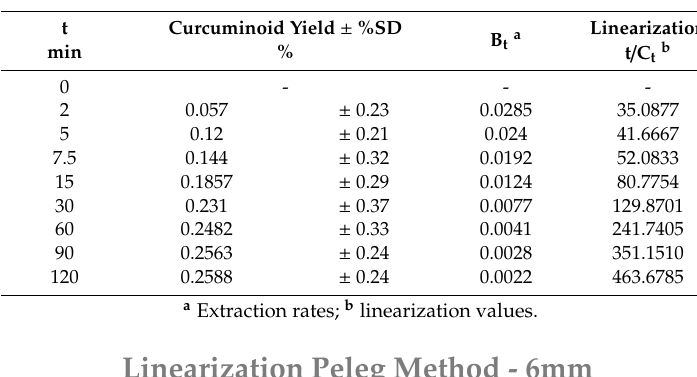
Table A1. Experimental UAE of 6 mm Curcuma longa L.